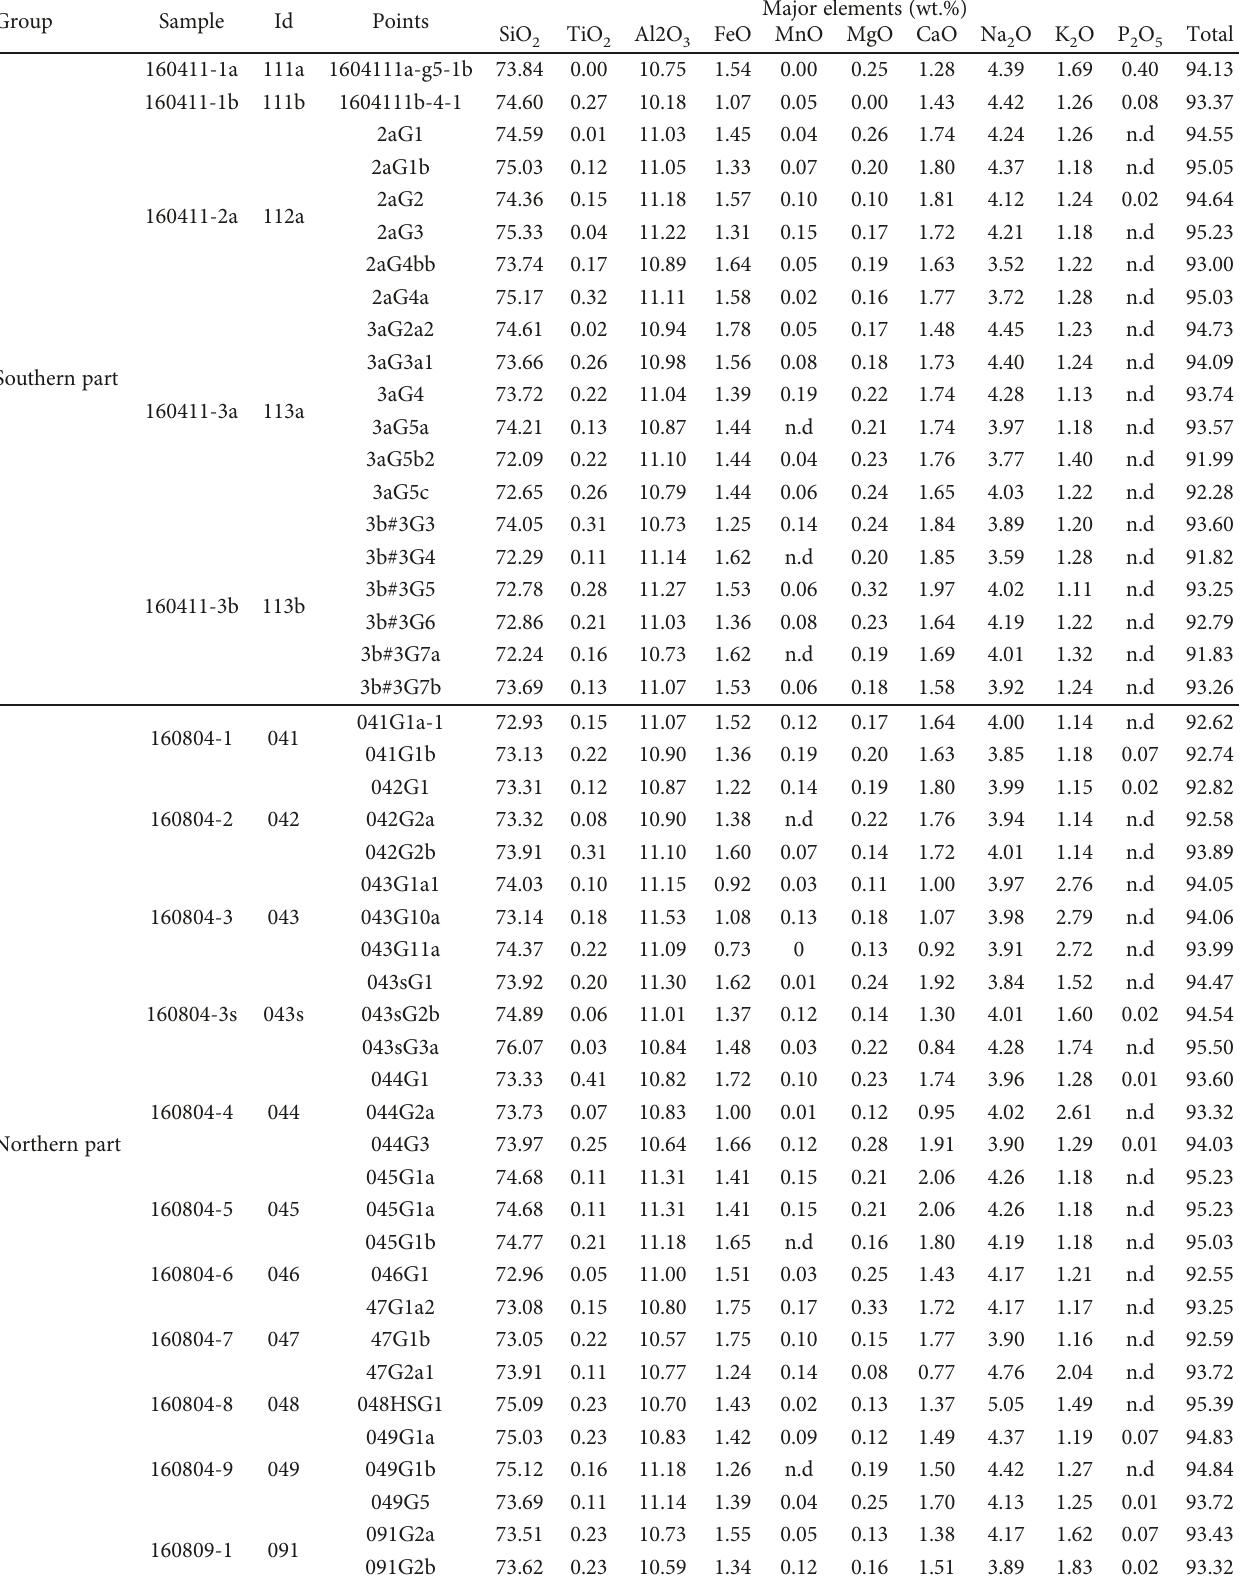
Table 2: Major element contents of melt inclusions from Fukano Caldera. Group